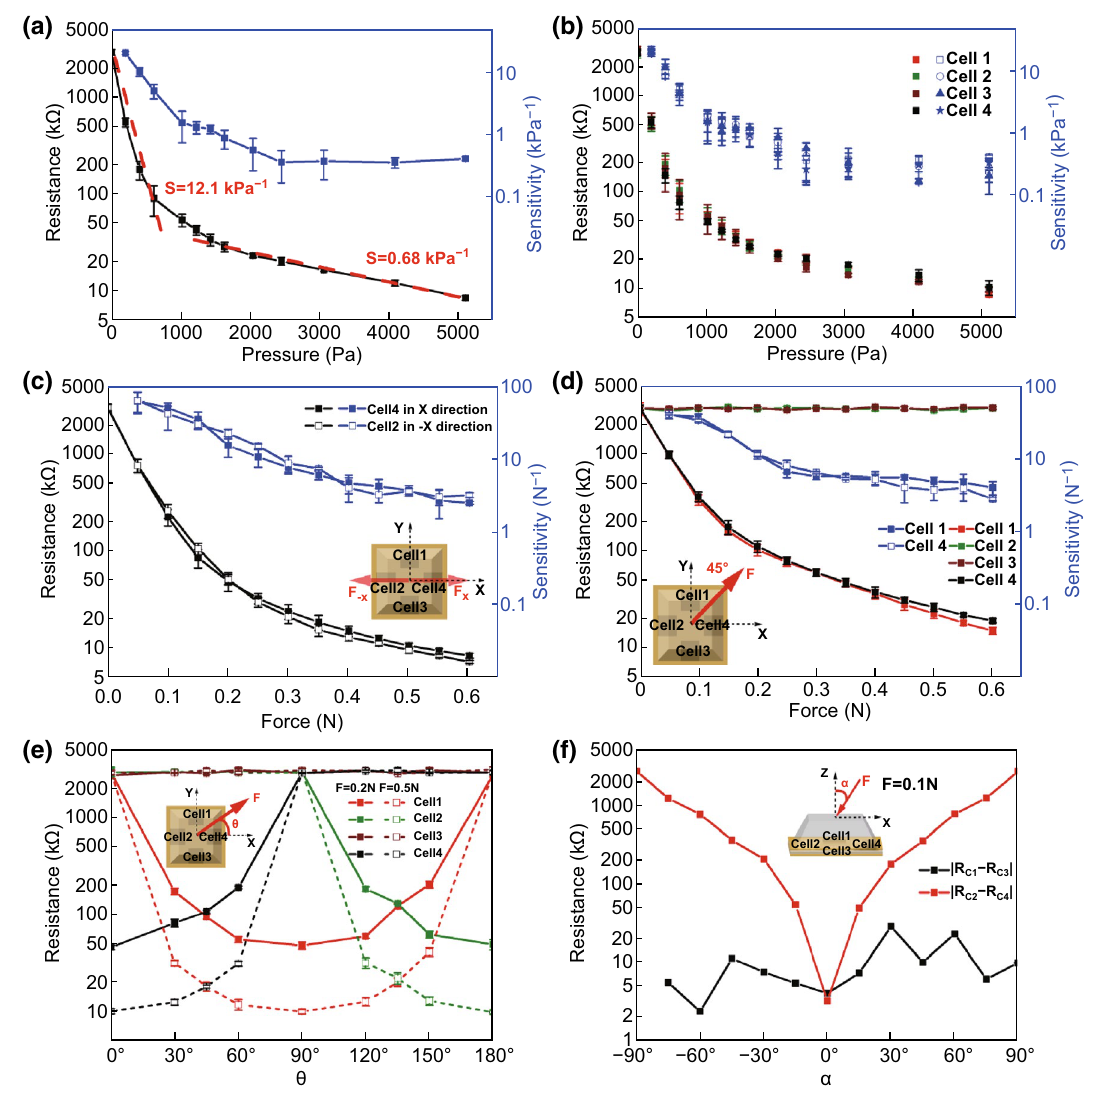
Fig. 4 a Resistance response and pressure sensitivity of the tactile sensor under normal pressure. The error bars represent standard deviations. b , c Resistance responses and sensitivities of different cells beneath the bump in one element under normal pressure and tangential forces in x direction and − x direction. d Response curves of cells under tangential forces in 45° direction. e Resistance change of each cell to angles in XOY plane (0° ≤ θ ≤ 180°), applied forces F = 0.2 and 0.5 N. f Absolute change of resistance difference of corresponding cells to angles in XOZ plane (− 90° ≤ α ≤ 90°), applied force F = 0.1 N. R C 1 , R C 2 , R C 3 and R C 4 represent the resistance of Cell 1, Cell 2, Cell 3 and Cell 4,